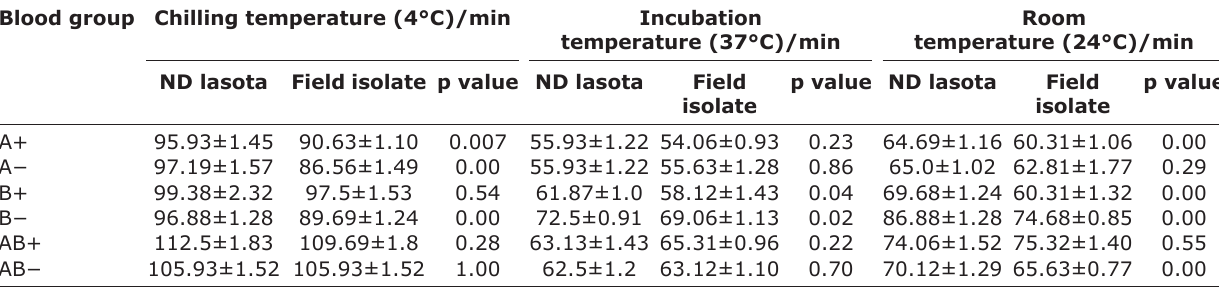
Table-9: Comparing HA of human RBC with two strains of NDV at different temperatures. Blood group Chilling temperature